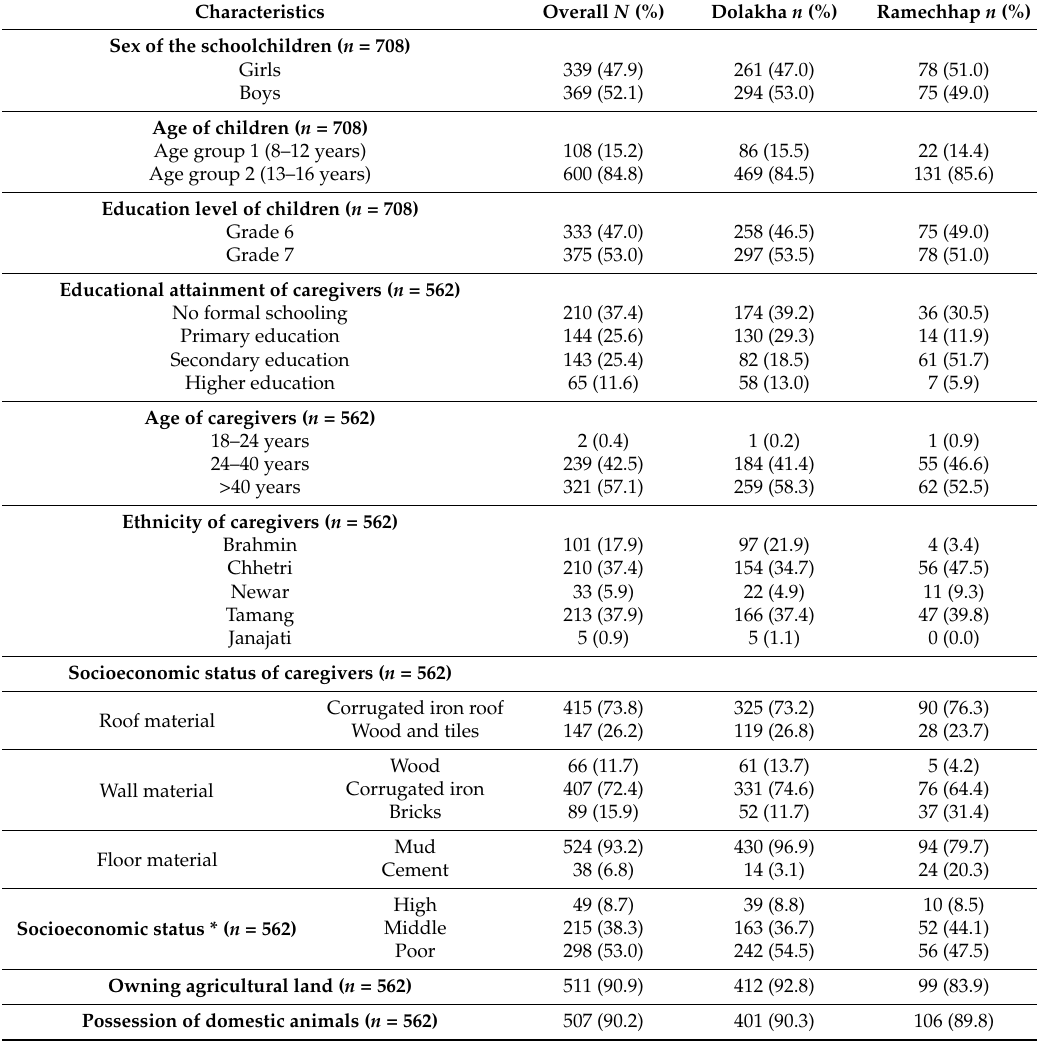
Table 1. Characteristics of study population in Dolakha and Ramechhap districts, Nepal, March–May 2015.